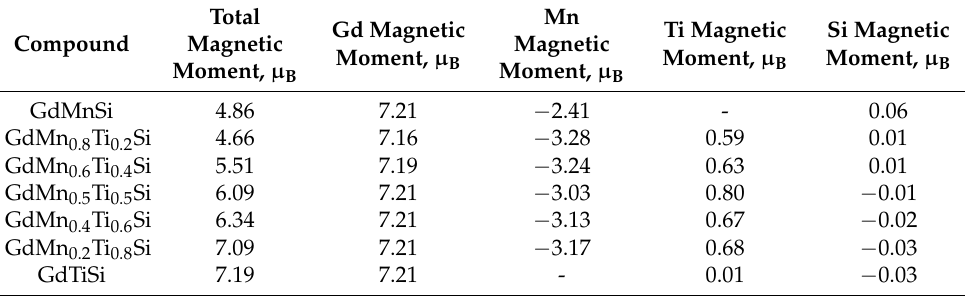
Table 1. The values of the total and partial spin densities of electronic states at the Fermi energy in GdMn 1- x Ti x Si for x = 0–1. Total Mn Gd Magnetic Compound Magnetic Moment, µ B Moment, µ B